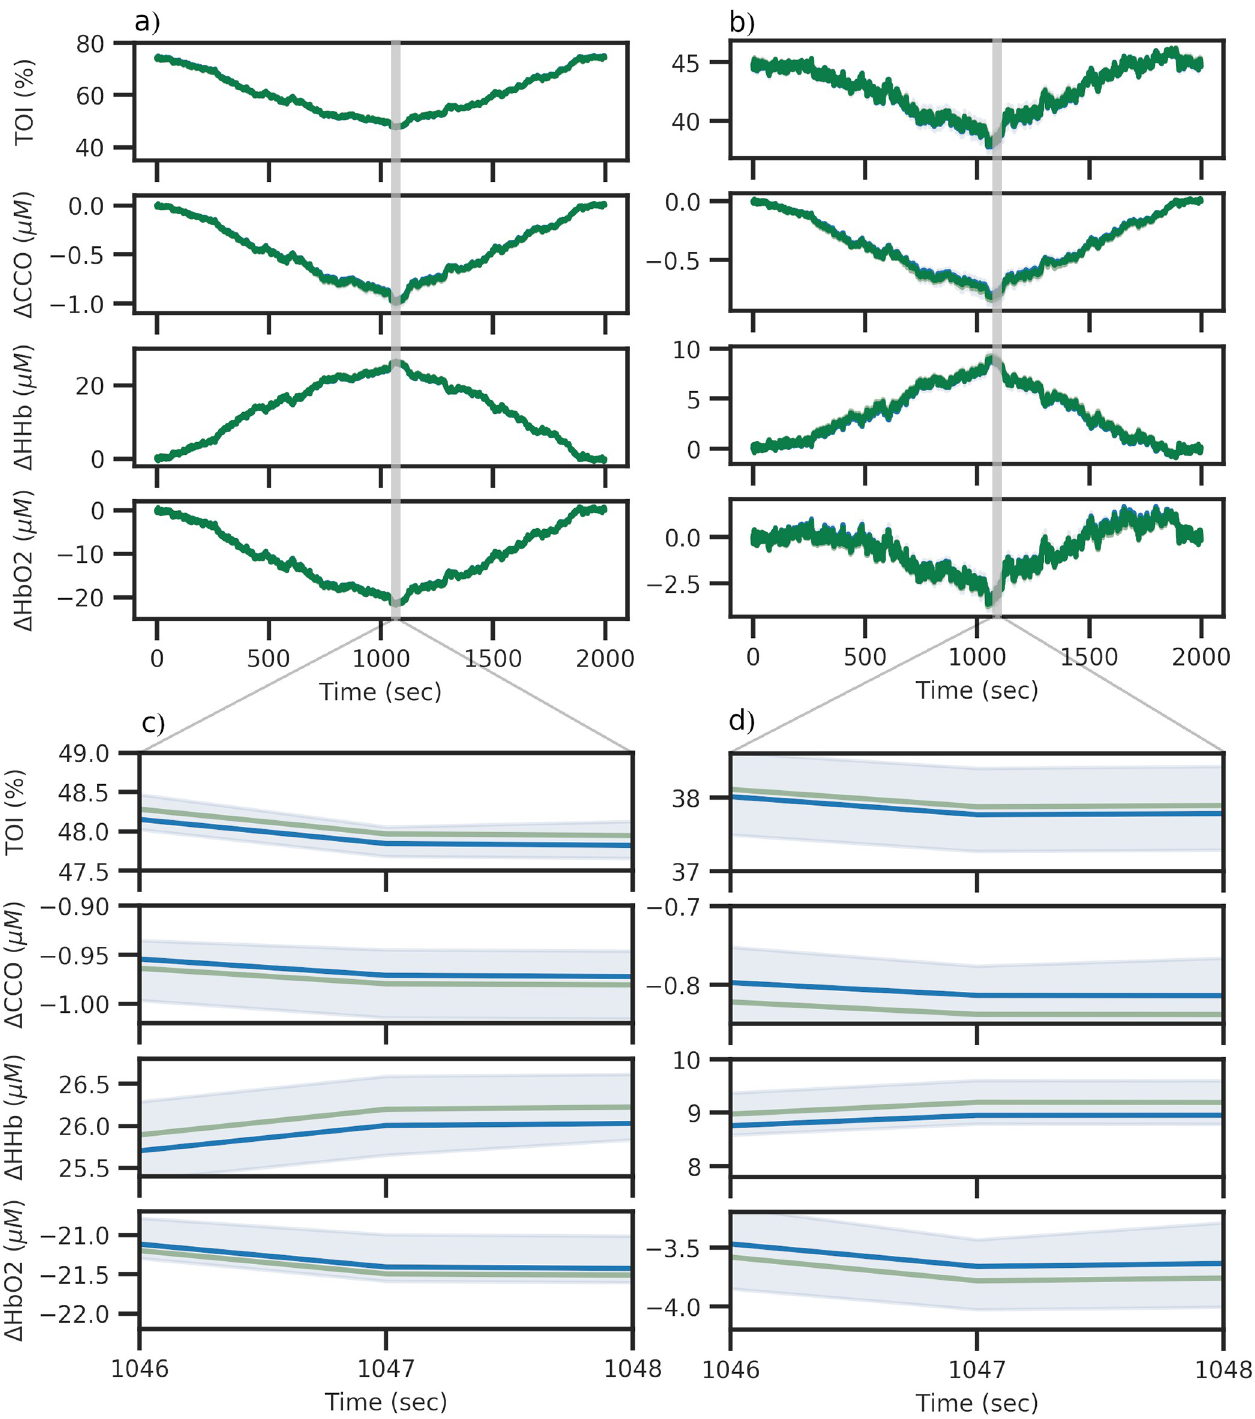
Fig 10. Comparison of predictions for healthy and impaired simulated data. Figures 10a and 10b show the predicted time series data from the healthy and impaired posteriors respectively. Each posterior was sampled 25 times and the resulting runs aggregated, with the median and 95% credible intervals plotted in dark blue and light blue respectively. Figures 10c and 10d show a zoomed in view of each output in order to show the credible interval of the posterior predictive distribution.